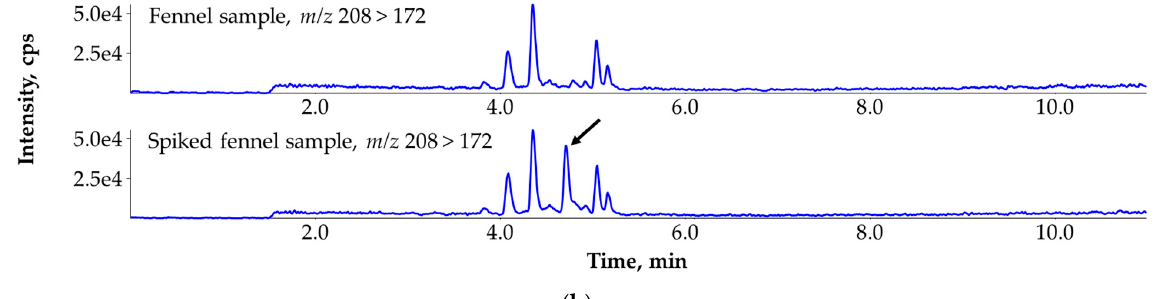
Figure 5. ( a ) Screening analysis of a fennel sample. The ion transitions of quinoclamine in a neat solvent calibrant (100 ng/mL, below) and in the sample (above). ( b ) Confirmatory analysis of the fennel sample for quinoclamine with standard addition. The 208 > 172 m / z ion transition (Rt = 4.71 min) was selective enough to make the correct decision on the sample. This ion trace appeared only in the chromatogram of the spiked sample (0.010 mg/kg, below). The arrow shows the appearance of signal in the expected retention time in the fortified sample due to the spiking.